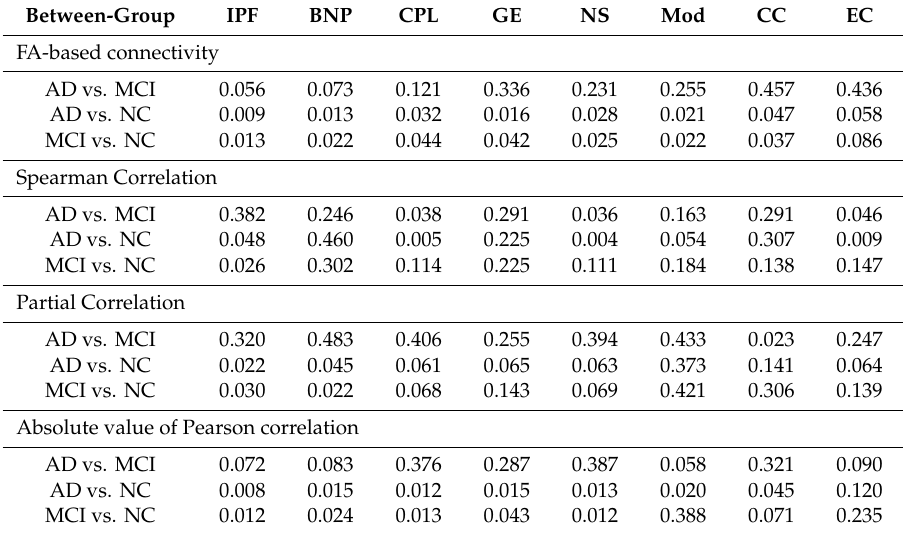
Table 4. Resulting p -values of di ff erences validated by di ff erent connectivity definitions.